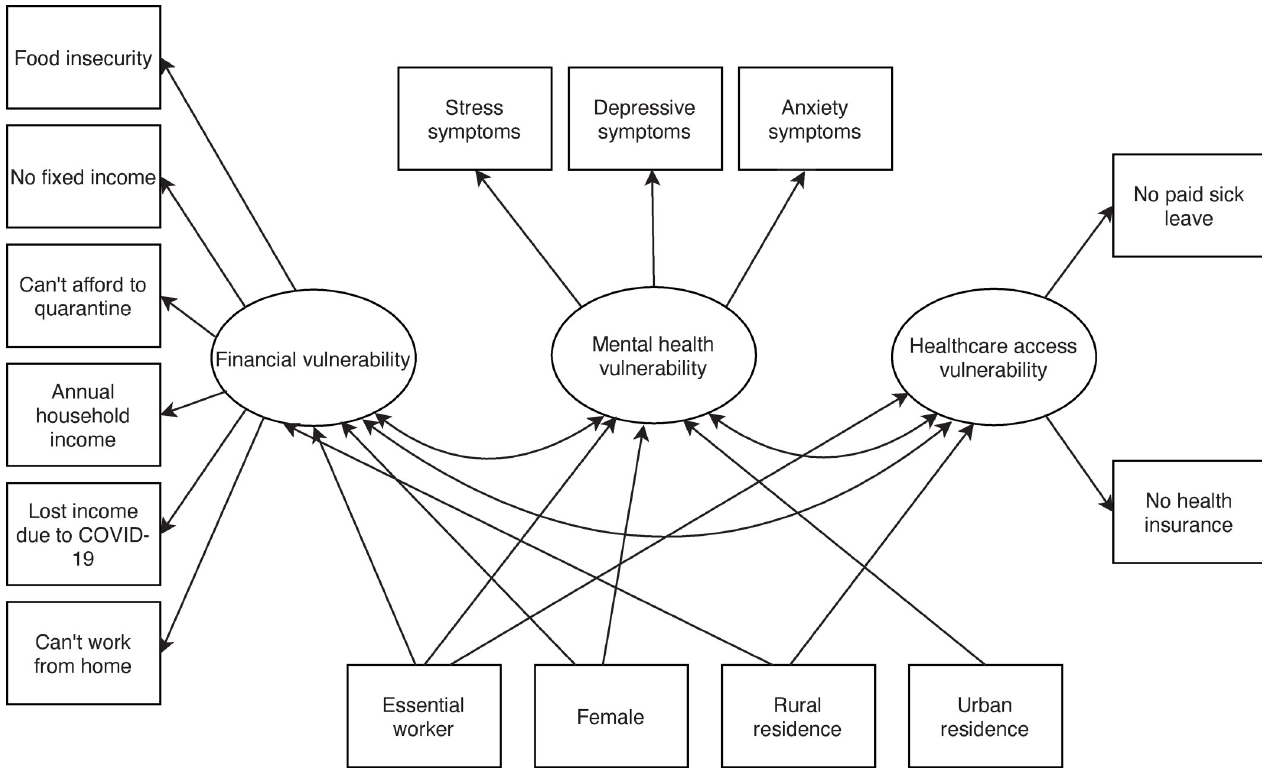
Fig 1. Conceptual model depicting the relationship of sex, essential worker and residence status to financial, mental, and healthcare access vulnerabilities during the COVID-19 pandemic among U.S. workers.